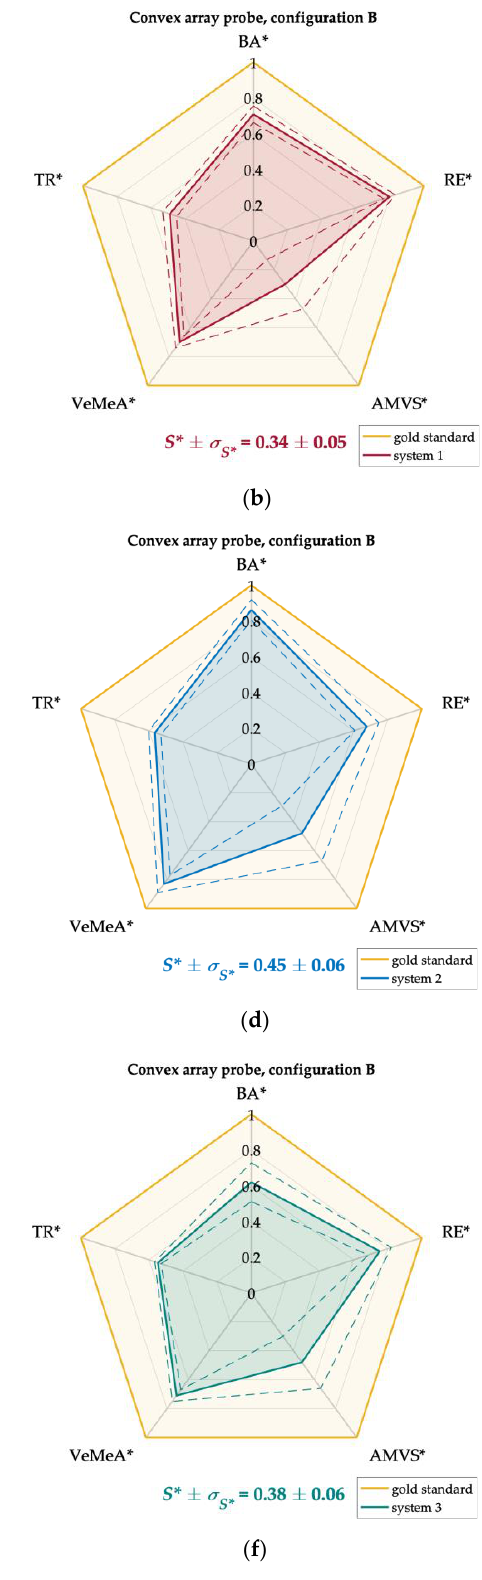
Figure 11. Kiviat diagrams for systems 1 ( a , b ), 2 ( c , d ) and 3 ( e , f ) equipped with convex array probes in configurations A ( a , c , e ) and B ( b , d , f ), for medium flow rate regime Q M . Each polygon area was normalized with respect to the gold standard one.